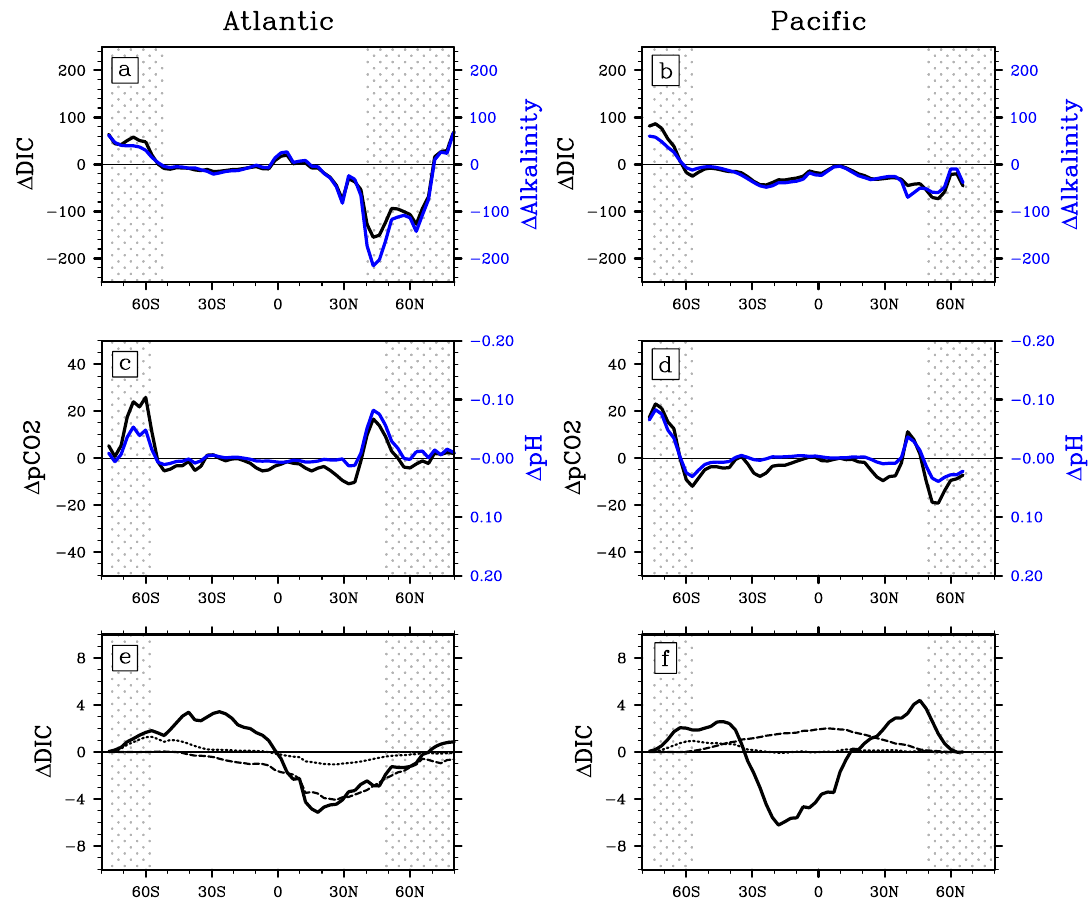
Fig. 13. ( a and b ) Zonal-mean ocean surface alkalinity (black) and DIC (mmolm − 3 ) (gray) difference between LGb and LGb-oc in the Atlantic and Pacific Ocean. Panels ( c and d ) are the same as ( a and b ) except ocean surface CO 2 concentration (ppmv) (black) and pH (gray) anomalies are weighted by the cosine of the latitude. Panels (e and f) are zonal-integrated DIC accumulation changes (TgC) due to ocean circulation (solid), the northern sea ice (dashed), and the southern sea ice (dotted). Dotted areas indicate the sea ice fraction of over 0.1 in